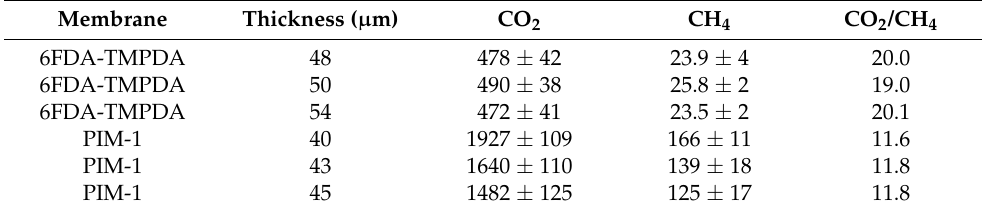
Table 10. Mixed gas CO 2 and CH 4 permeabilities (barrer) through 6FDA-TMPDA and PIM-1 composite membranes with Teflon AF1600, denoted by overall membrane thickness, at 35 ◦ C.